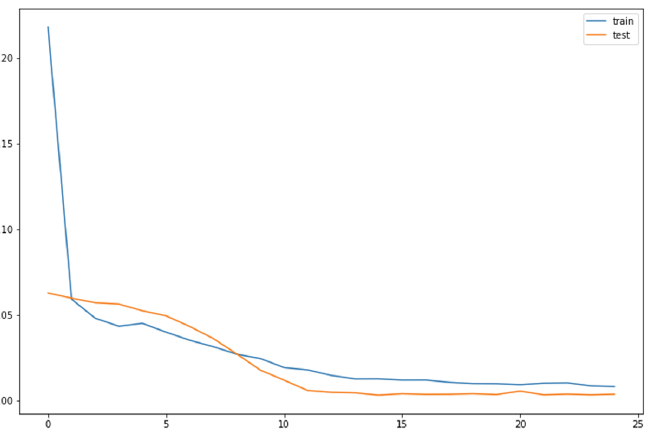
Figure 14. RMSE for train and test sets over 25 epochs without the usage of the proposed prefetch